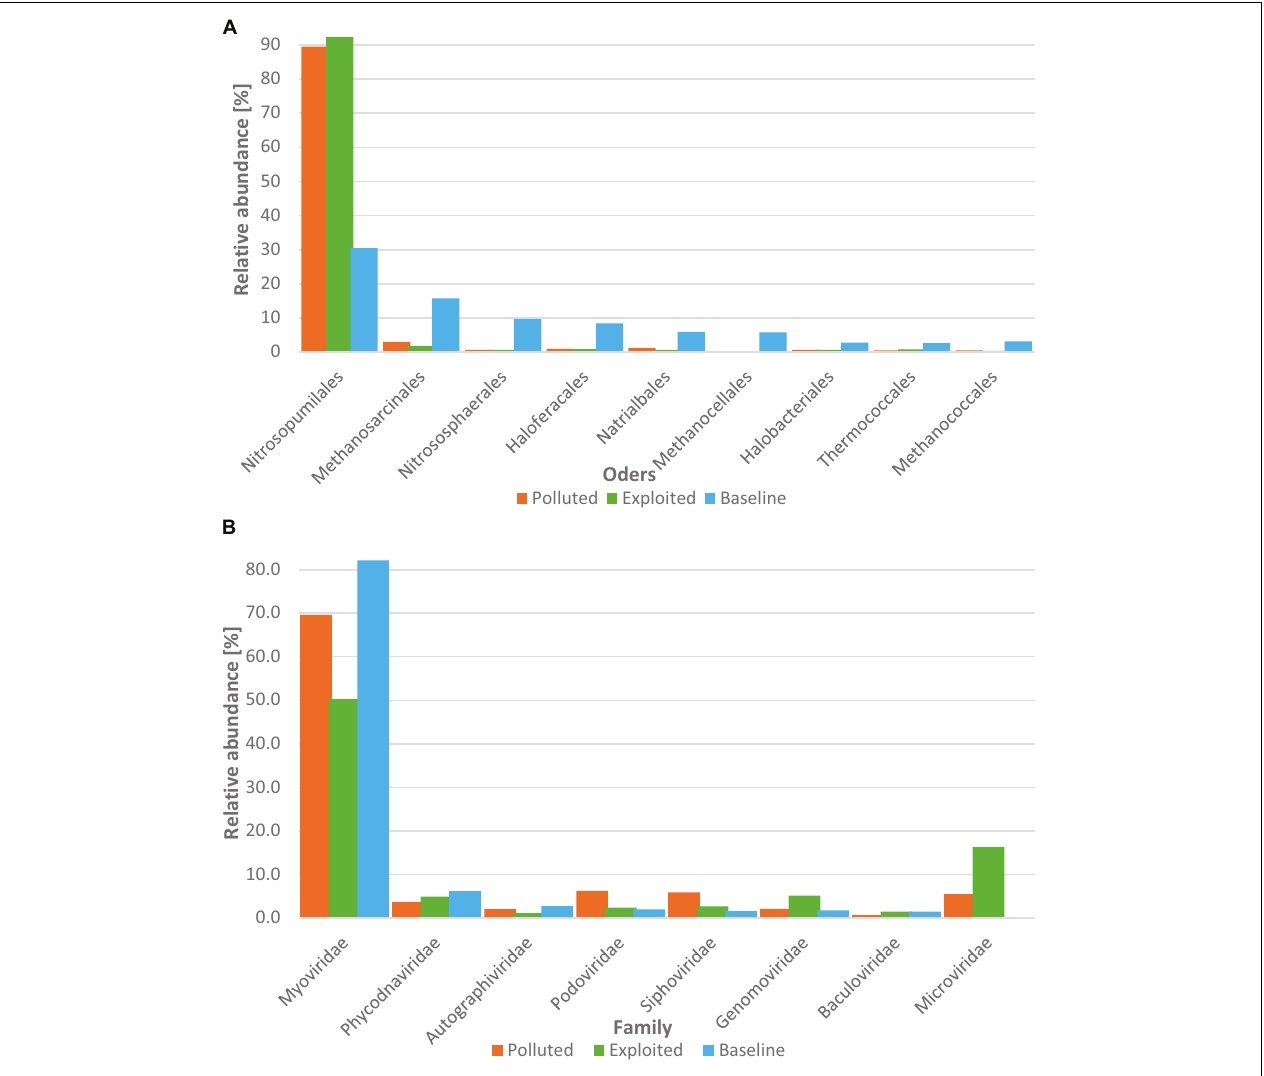
FIGURE 5 | Distribution of (A) archaeal orders and (B) viral families with overall relative abundance > 1% grouped by study site i.e., “polluted” (bronze), “exploited” (olive) and “baseline”